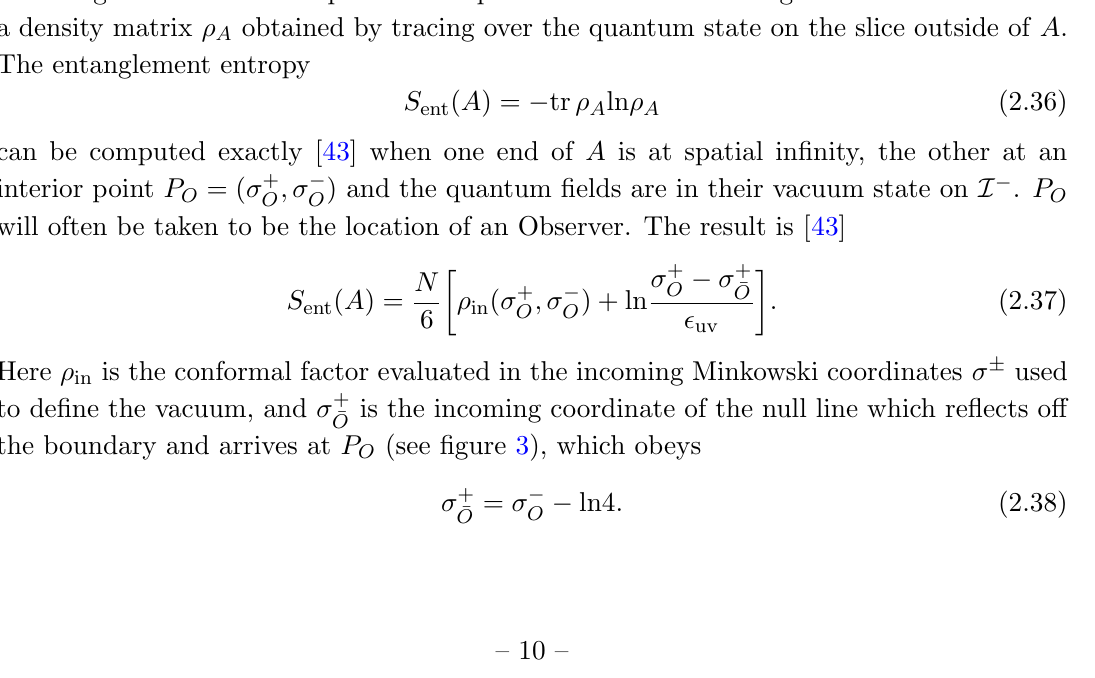
Figure 3 . Points are labeled by ( (cid:27) + by re(cid:13)ecting across the timelike